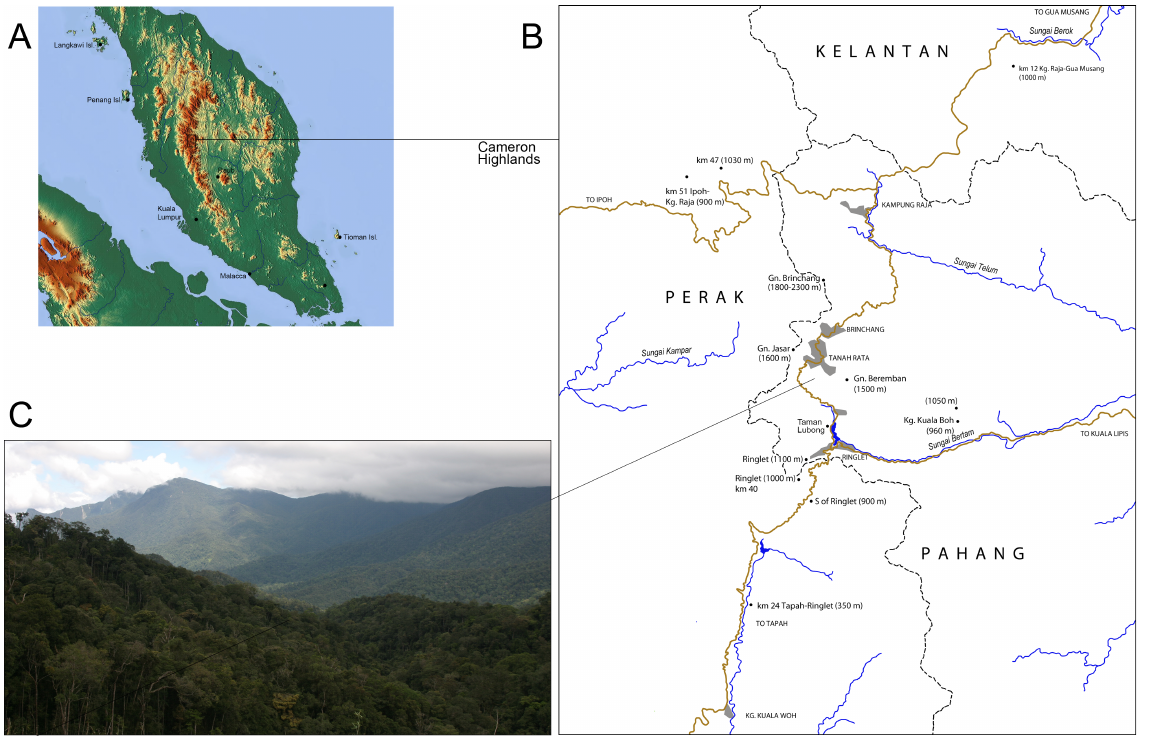
Fig. 1. the sampled localities in the Malay Peninsula. A . the localities in the Malay Peninsula. B . Detailed map of sampled localities in the Cameron Highlands region. C . Habitats in the cameron Highlands